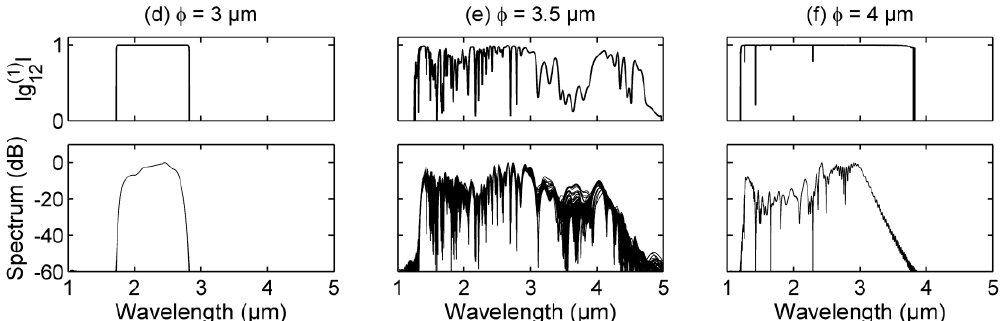
Figure 5. ( a ) Evolution of the average supercontinuum (SC) spectrum calculated from an ensemble of 100 simulations for each fiber core diameter of the step-index tellurite fiber (black dashed lines indicate the position of zero-dispersion wavelengths (ZDWs)). The fiber length was fixed to 12 cm, and the input peak power of 200-fs pulses at 2300 nm was set to 3 kW (equivalent to 600-pJ pulse energy, see Section 4). ( b ) Corresponding evolution of the modulus of the complex degree of first-order coherence (black dashed lines indicate the position of ZDWs). ( c ) Corresponding soliton number calculated at pump wavelength as a function of input pulse and fiber parameters. ( d – f ) Corresponding profiles of 100 simulated power spectra and calculated degree of coherence obtained for three distinct core diameter 3, 3.5, and 4 µm, respectively.